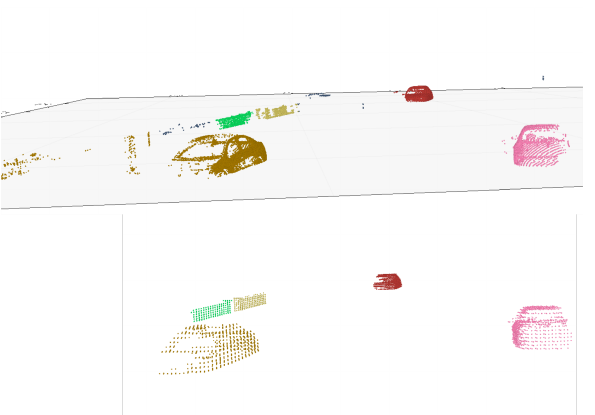
Figure 9. Visualization of the points labeled as car clustered and colored in single random color per cluster: before (upper part) and after region growing (lower part).